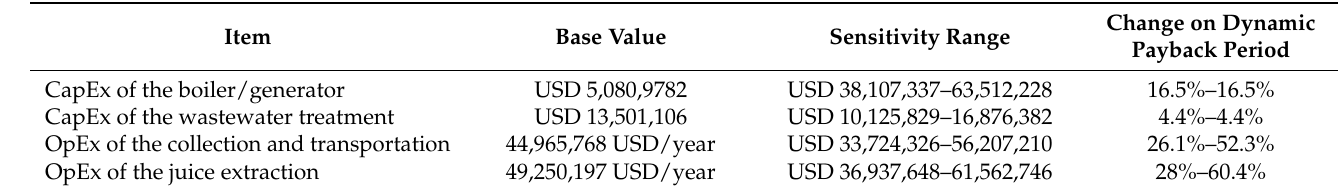
Table 5. Sensitivity analysis of key CapEx, OpEx, and revenue items on the discounted payback period of the biorefinery a,b